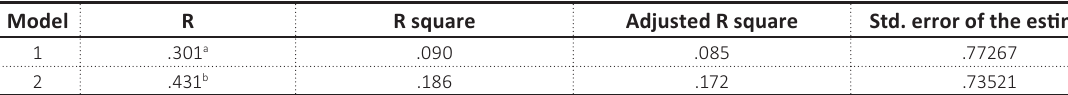
Table 5. Model summary